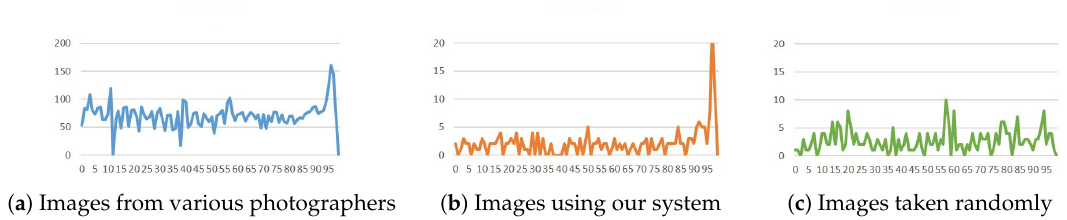
Figure 40. Results for the horizontal composition method.